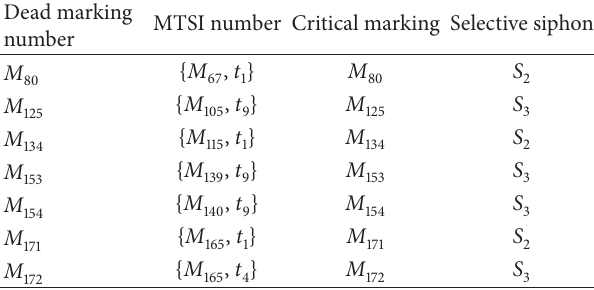
Table 7: The relation between type I CMTSIs and selective